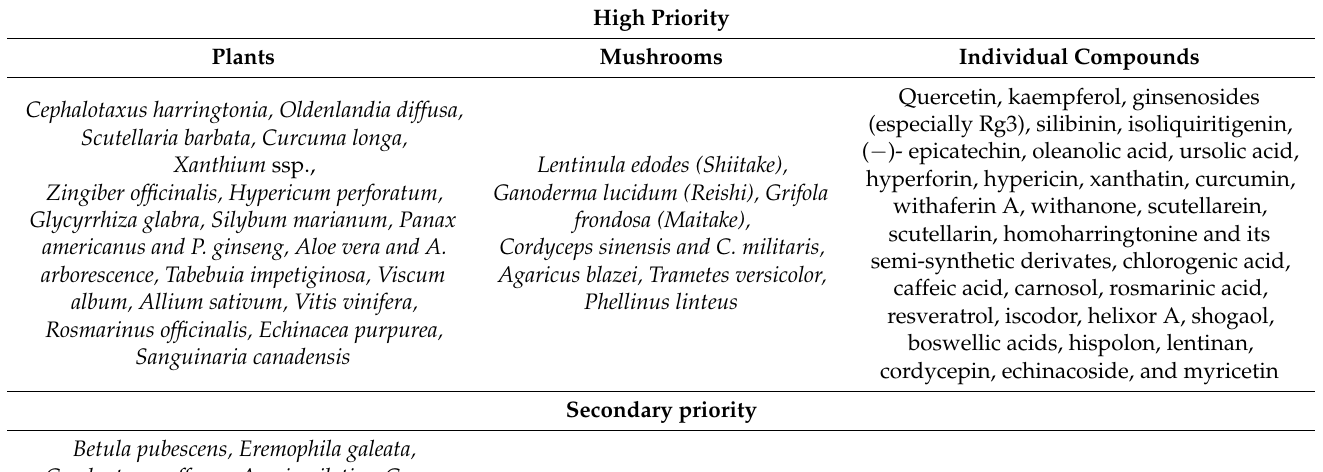
Table 8. Selected plants, mushrooms, and their active compounds in the order of their priority to study anticancer capabilities. The priority was suggested based on the available information about the anti-neoplastic efficacy and safety in preclinical and clinical